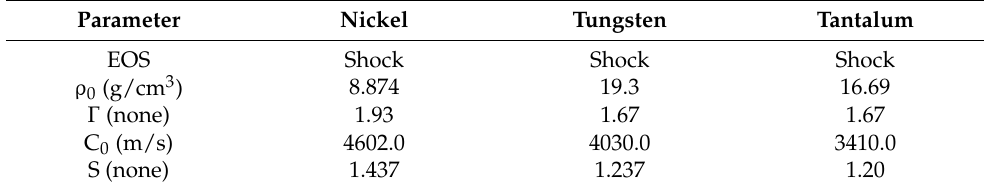
Table 2. The EOS parameters of nickel, tungsten and tantalum.